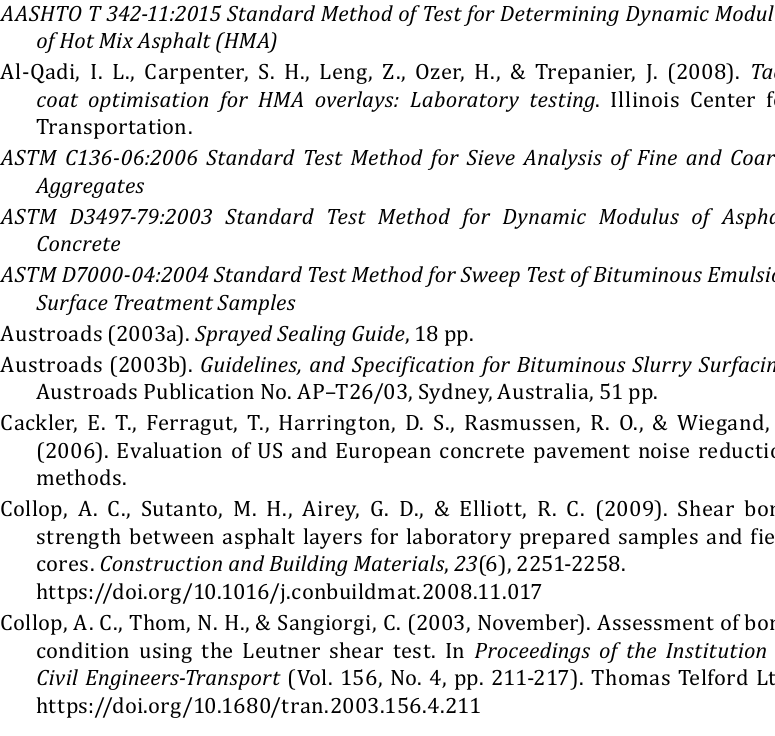
coat optimisation for HMA overlays: Laboratory testing